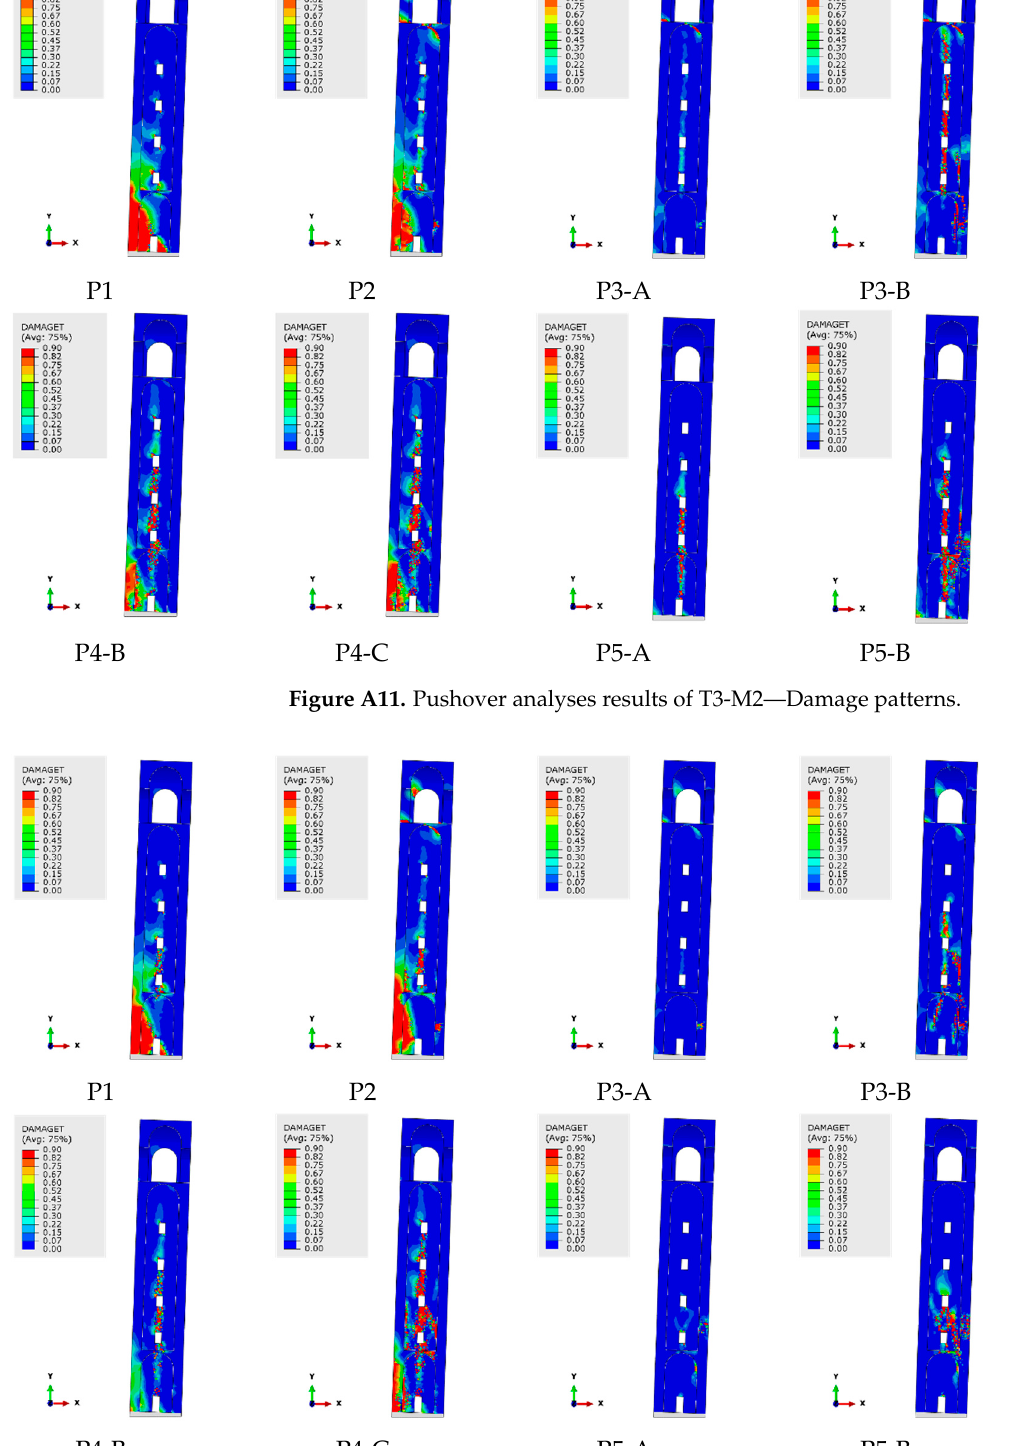
Figure B9. Pushover analyses results of T3-M3—Damage patterns.